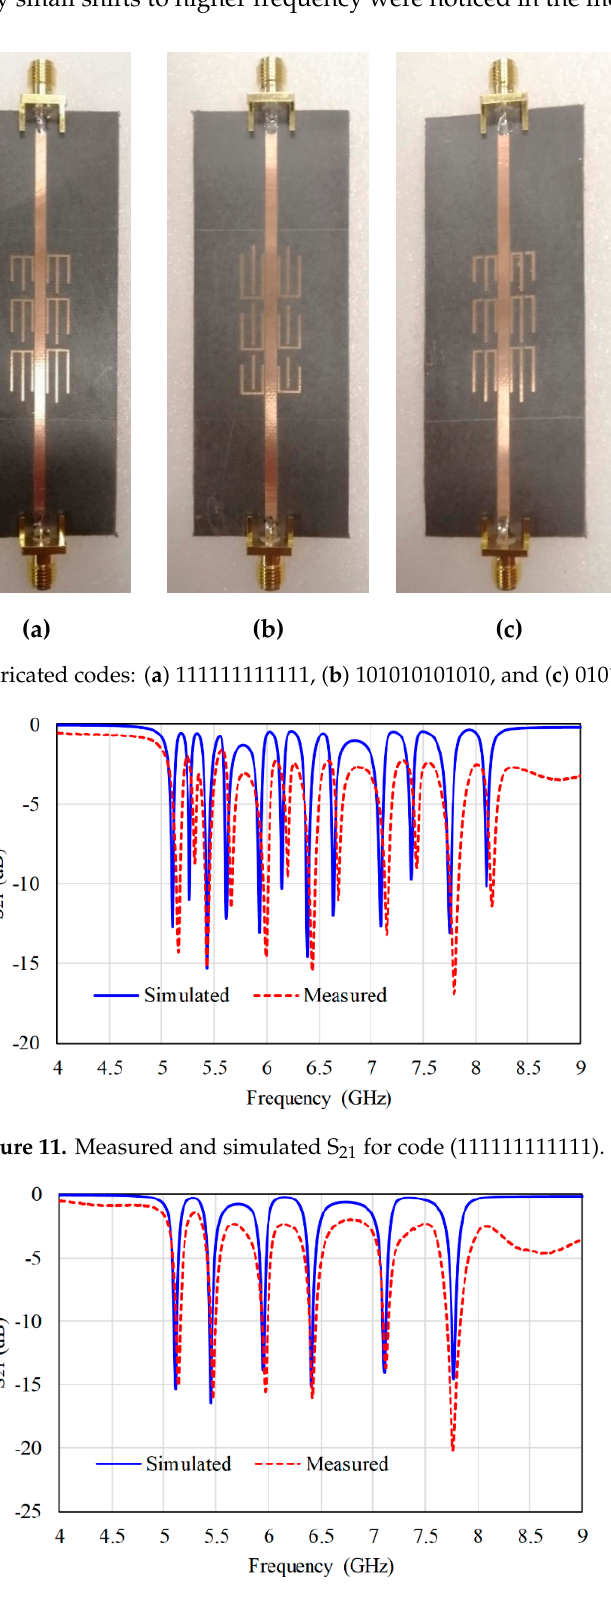
Figure 12. Measured and simulated S 21 for code 101010101010.